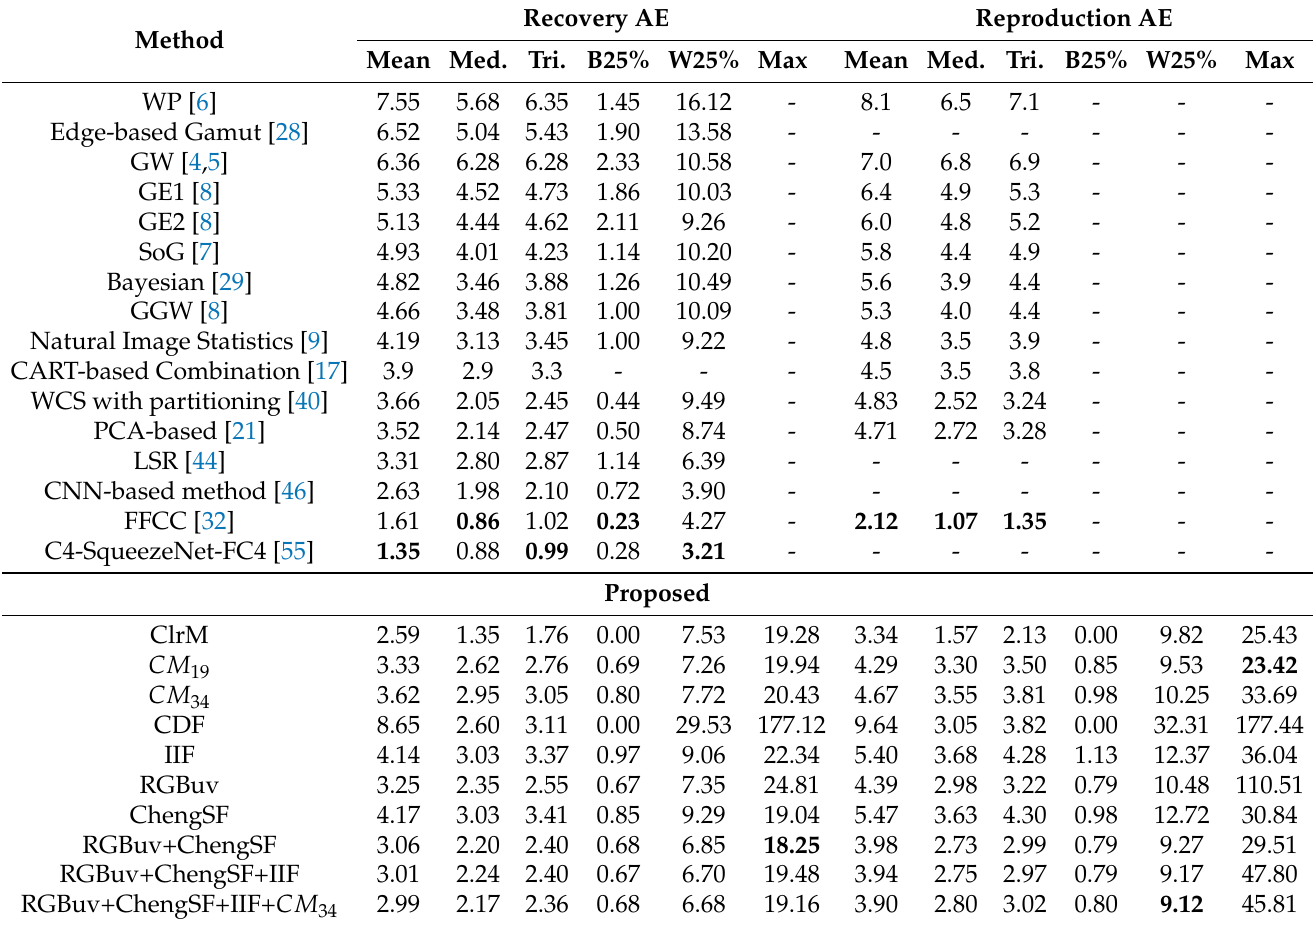
Table 1. Comparative performance metrics between our method and some statistics-/learning-based methods on the Gehler-Shi dataset. The statistical metrics of the conventional methods are cited from [40] and the related